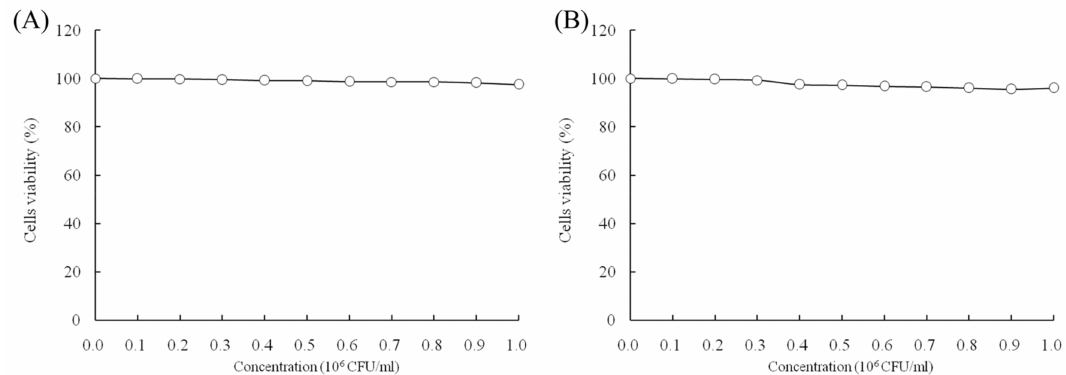
Figure 1. Effects of Lactobacillus casei strain Shirota (LcS) ( A ) and geniposide ( B ) on the growth of HOK normal oral epithelial cells.